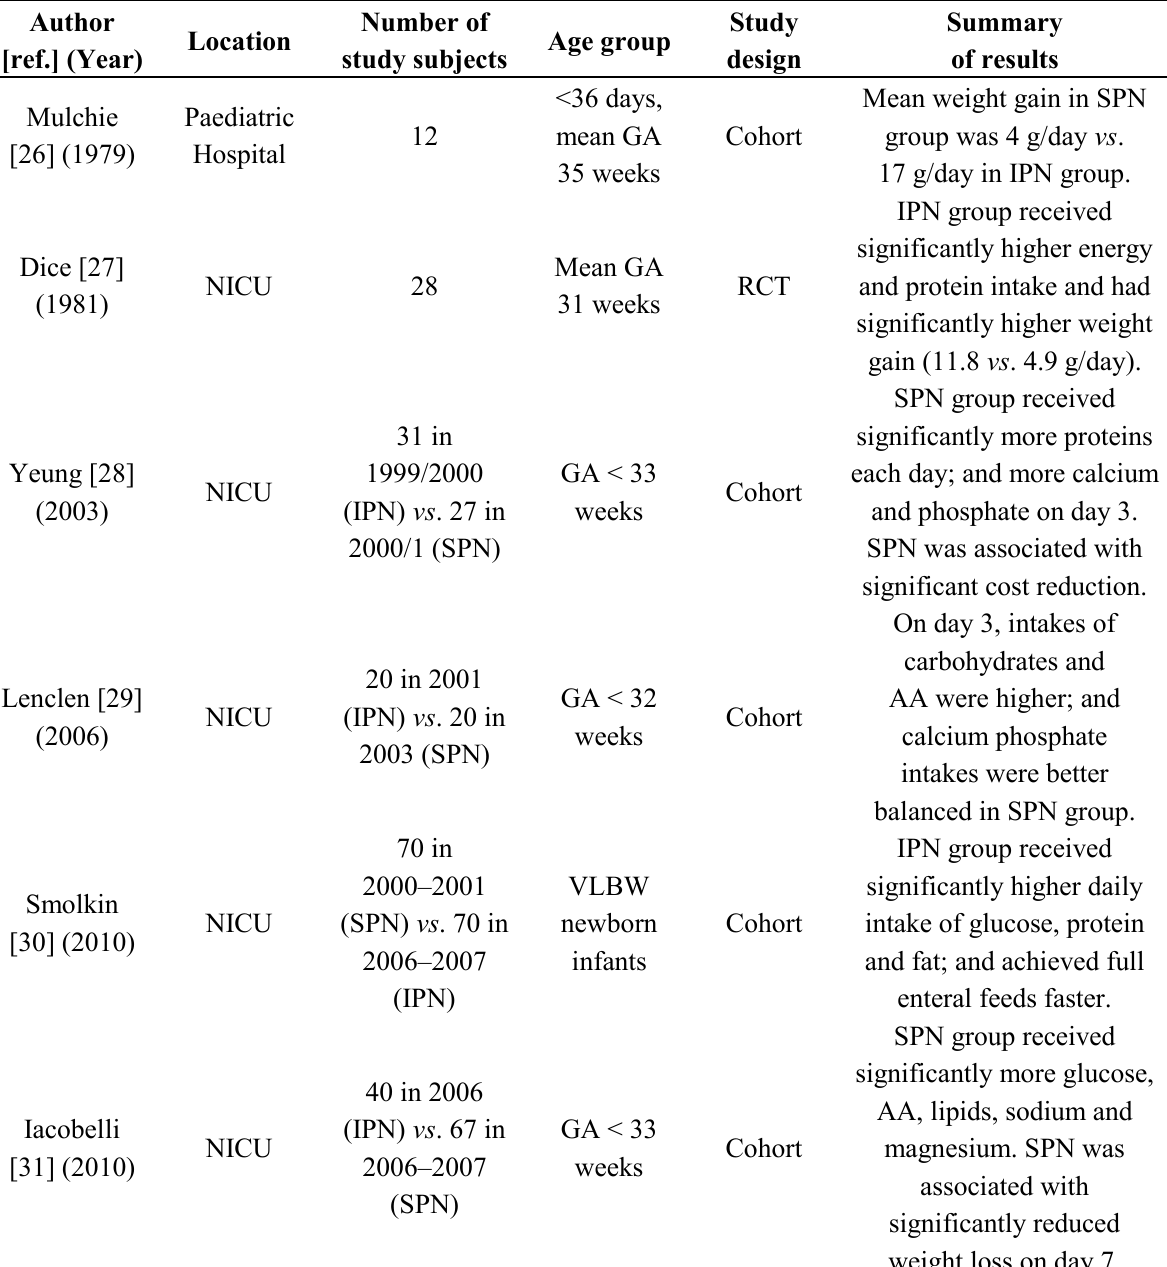
Table 1. Standardised vs . individualised PN—studies in